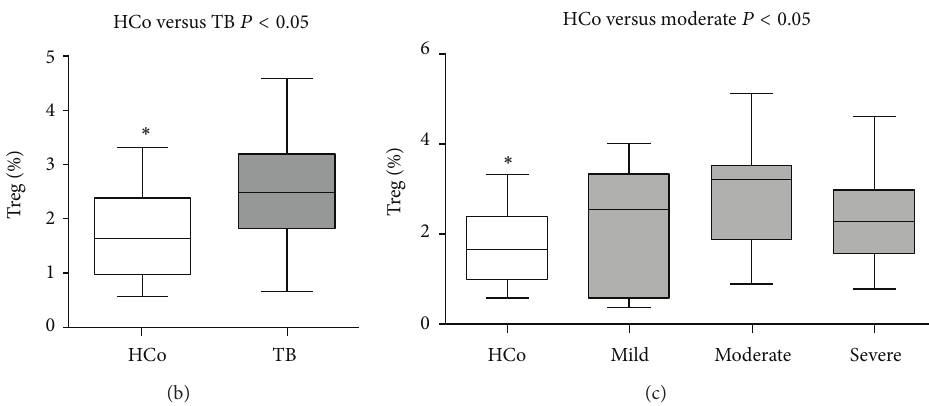
Figure 1: CD4+CD25+FoxP3+ T cells (Tregs) frequency in TB patients. (a) Plot of cytometric analysis from a representative sample: (I) FSC and SSC identifying mononuclear cells, (II) CD4+ cells within the lymphocyte gate, (III) assessment of FoxP3+ cells gated on the CD4+ cells as shown in panel II, (IV) isotype control from the same sample, and (V) an additional control showing that the CD4+FoxP3+ population is also CD25 high. (b) Treg % comparisons between HCo and TB. (c) Comparisons of disease severity of TB patients. Box plots show median values, 25–75 percentiles of data in each group with maximum and minimum values. HCo: healthy controls.